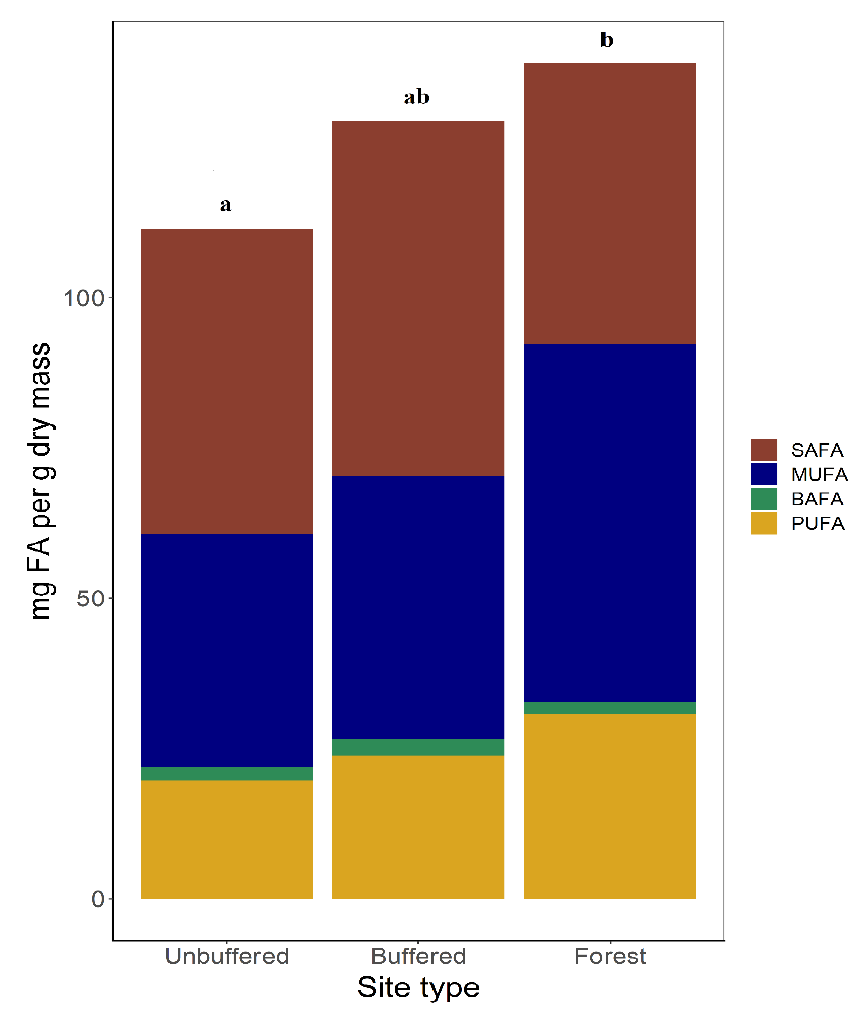
Figure 5. Mean proportion in mg per g dry mass of fatty acids in spiders at the different site types. SAFA: Saturated fatty acids, MUFA: Monounsaturated fatty acids, BAFA: Bacterial fatty acids, PUFA: Polyunsaturated fatty acids. Letters above the bars denote homogenous subsets based on Tukey’s post-hoc testing of differences among groups for total FAs. Table 1. Results of mixed-effects model ANOVAs testing site type, spider family and their interaction on PUFAs (% of total FA and mg PUFA per g dry mass).